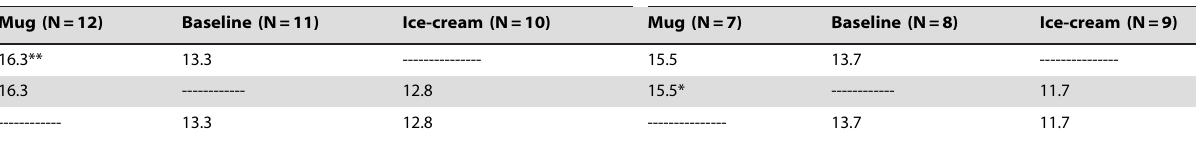
Pairwise Comparison between Male Pairwise Comparison between Female